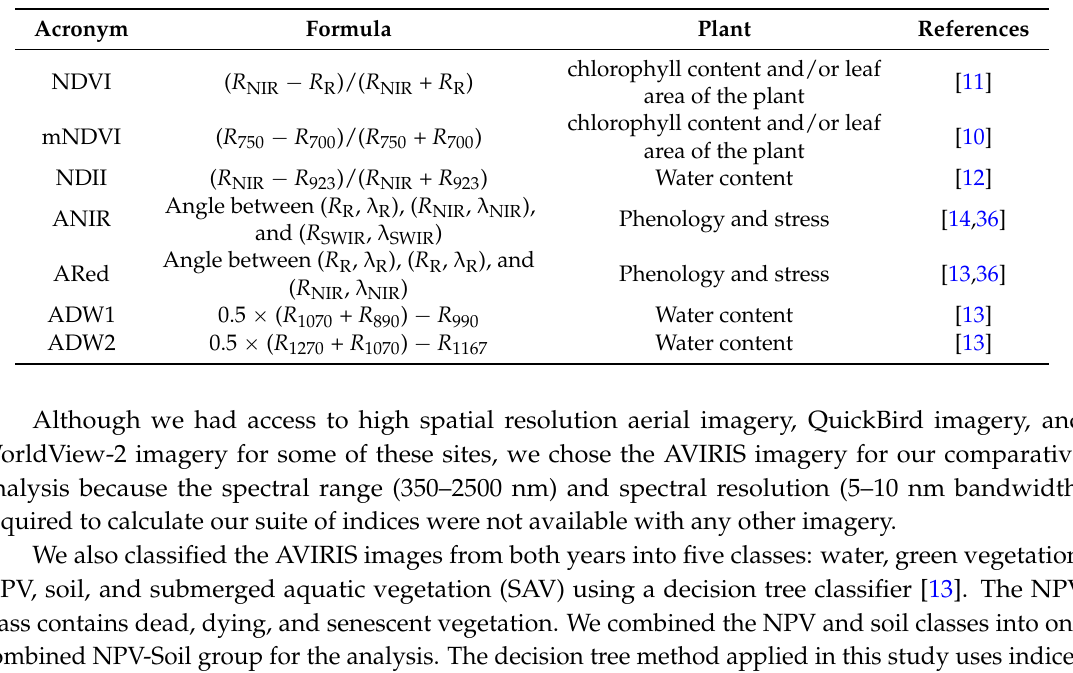
Table 2. Seven indices chosen to study severity of oil impact. R R , R NIR and R SWIR are the reflectance values in the Red, Near-Infrared (NIR), and Shortwave-Infrared (SWIR) bands, respectively, and λ R , λ λ NIR , and SWIR are the center wavelengths for the Red, NIR and SWIR